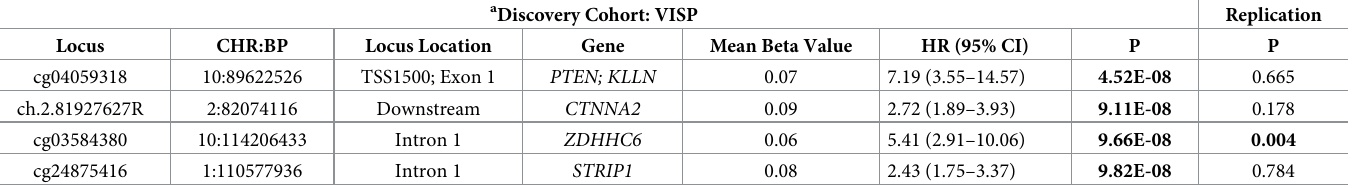
Table 2. Significant methylation loci associated with time to VISP recurrent stroke in AFR (p �